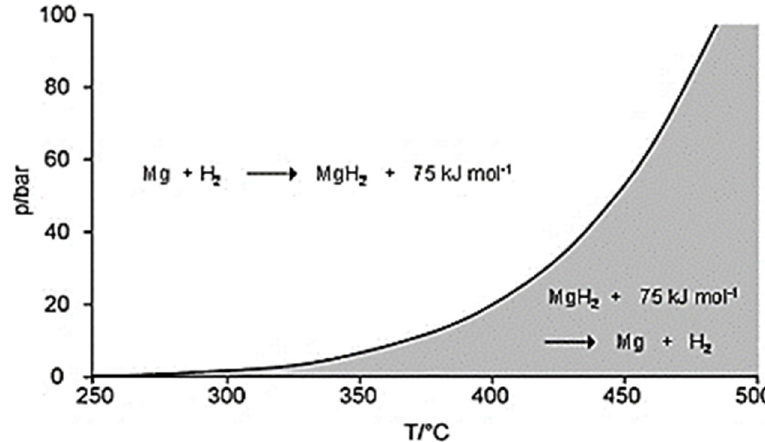
Figure 3. Equilibrium pressure of MgH 2 as a function of temperature [39].